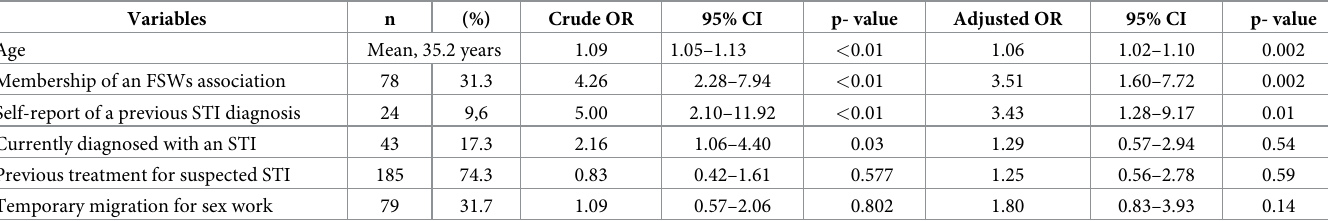
Table 2. Univariate and multivariable analysis of factors associated with RSP among FSWs of this study.